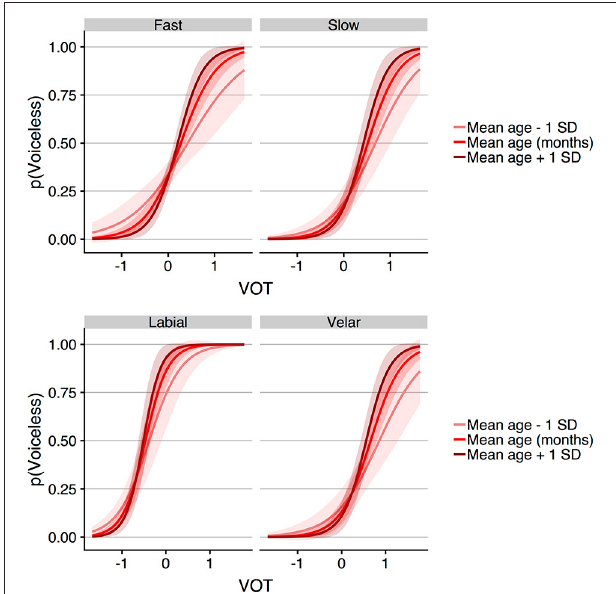
FIGURE 4 | The (Top) shows the results of the GLMM predicting voiceless responses in the child participants as a function of VOT, speaking rate, and age (in months). To illustrate the VOT by age interaction, the effect of age is shown at the mean age and at one standard deviation above and below the mean age. The (Bottom) shows the parallel GLMM analysis for the place of articulation model. In both panels, the interaction between age and VOT reflects the slope of the predicted identification function becoming steeper as age increases. The shaded regions around the functions in the both panels indicate the 95% confidence interval region. In the GLMMs, VOT (in ms) was entered into the model scaled and centered around the mean, which is shown as 0 on the abscissa in each